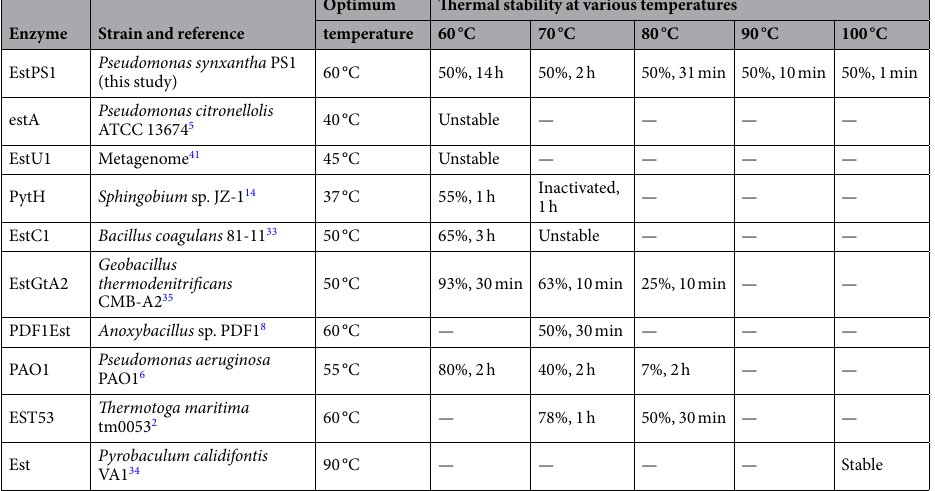
These results indicate that recombinant EstPS1 was more thermotolerant than most of the reported carboxy- lesterases. A comparison of the thermostability of different sources of carboxylesterases at various temperatures is shown in Table 3. However, the most thermostable carboxylesterase that has been identified is Est from a hyperthermophilic archaeon; the activity of the enzyme did not decrease after 2 h at 100 °C 34 . Est showed higher hydrolytic activity towards esters with short to medium chains, with p -nitrophenyl caproate (C6) being the best substrate among the p -nitrophenyl esters examined. EstPS1 showed no activity toward p -nitrophenyl myristate and p -nitrophenyl palmitate. The activity toward the p -nitrophenyl esters of medium-chain fatty acids was lower than that toward p -nitrophenyl butyrate. Therefore, the kcat/Km ratios indicated that the activity of EstPS1 was higher than that of Est towards p -nitrophenyl butyrate. The EstPS1 of P. synxantha was stable at pH 6.0–9.0 com- pared with that of P. aeruginosa PAO1 (pH 4.0–8.0) 6 , Geobacillus thermodenitrificans (pH 6–10) 35 , Sphingobium erides (tributyrin) and has low activity towards long-chain triglycerides. EstPS1 showed the highest activity with p -nitrophenyl butyrate, and its activity was decreased with increasing aliphatic chain length. Lipolytic activity was very low for esters containing an aliphatic chain length longer than 10 carbon atoms, indicating that EstPS1 is a carboxylesterase and not a lipase. Indeed, lipases prefer substrates with relatively long aliphatic chains. The Km value of EstPS1 was 43 μ M when p -nitrophenyl butyrate was used as a substrate (Table 2). This is similar to other reported carboxylesterases including those from Pyrobaculum calidifontis (44 μ M) 34 and Archaeoglobus fulgidus